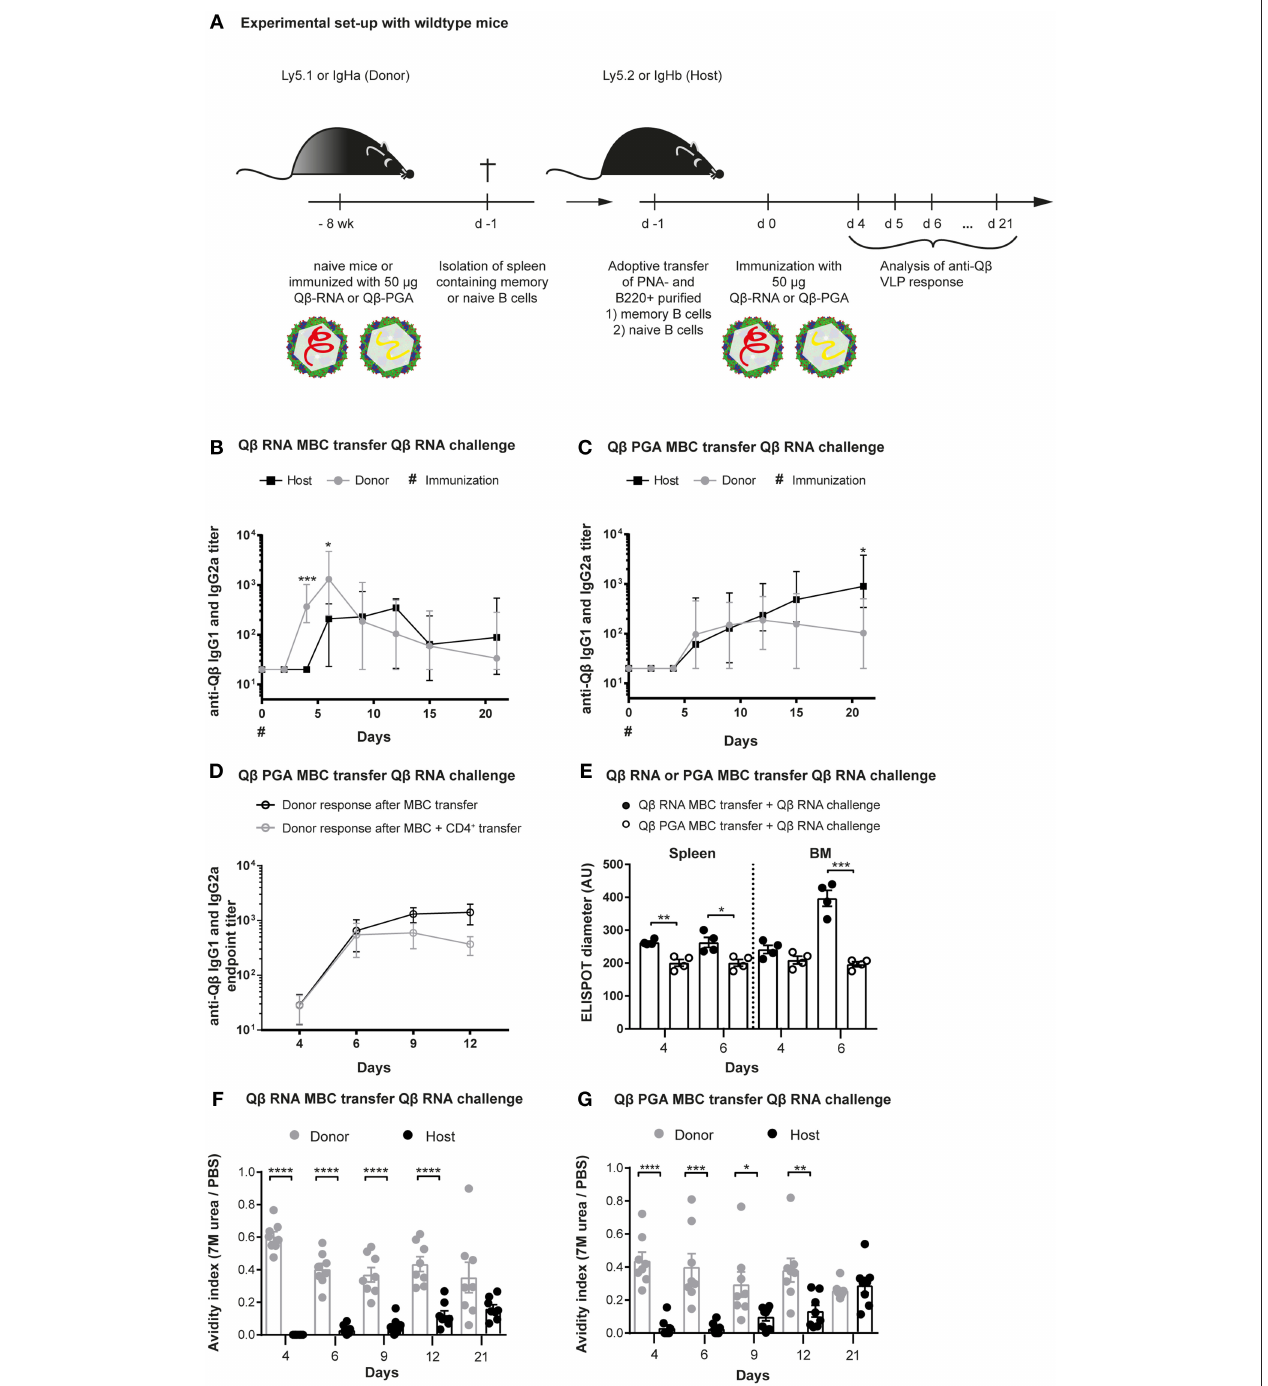
FIGURE 1 | Memory B cells generated in presence of bacterial RNA generate secondary PCs after challenge with VLPs containing RNA. (A) Congenic mice (Ly5.1 or IgHa) were immunized with 50 µ g Q β VLPs containing RNA (B,E,F) or polyglutamic acid (PGA) (C–E,G) i.v. Eight weeks after immunization spleens of immunized and naïve mice were isolated and PNA − B220 + (B,C,E–G) and CD4 + (D) MACS purified cells were transferred into host mice (Ly5.2 or IgHb). Recipient mice were immunized with 50 µ g Q β -RNA or Q β -PGA i.v. 1 day after the transfer. Spleens, bone marrow, and serum were taken at several time points after challenge. (B,C) The anti-Q β IgG1 and IgG2a antibody titers in the serum were determined by ELISA. Ha and Hb allotype specific detection antibodies were used to discriminate between donor (IgHa, gray circles) and host (IgHb, black squares) responses. (D) The endpoint titer of anti-Q β IgG1 and IgG2a antibodies in the serum was determined by ELISA. Donor-derived responses after memory B cell (black open circles) or memory B cell and memory CD4 + T cell (gray open circles) transfer were detected using